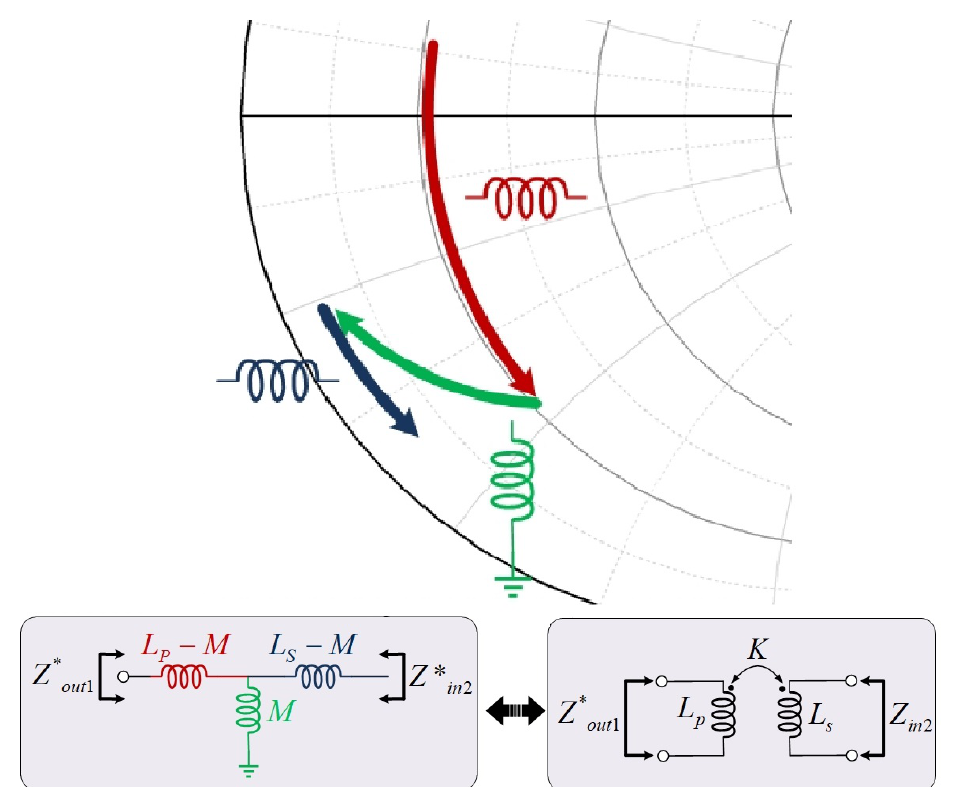
Figure 6. Smith chart of the inter-stage matching network with transformer T-model and its equivalent